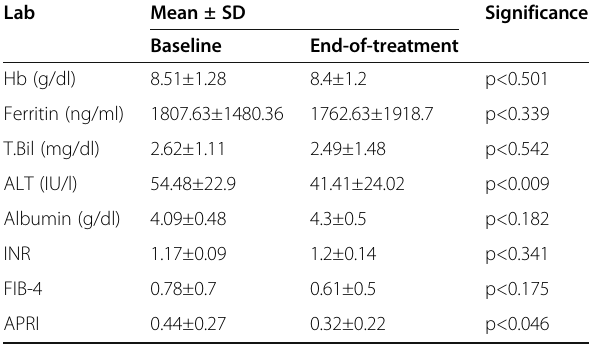
Table 2 Comparison between baseline and end-of-treatment